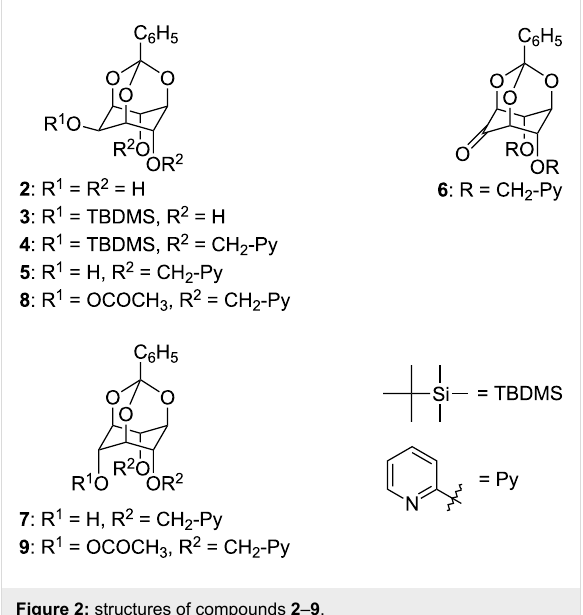
Figure 2: structures of compounds 2 – 9